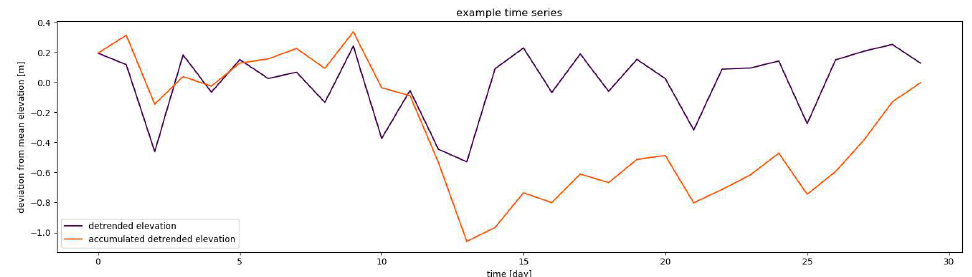
Figure 1. Time series preparation. In purple, a de-leveled time series is shown, obtained by removing the mean elevation over all epochs from each epoch. In orange, the cumulative representation of the same time series is shown, obtained by summing up the consecutive deviations from the mean. Note that such cumulative time series always ends at zero. This time series of PLS-KIJKDUIN consists of 30 consecutive